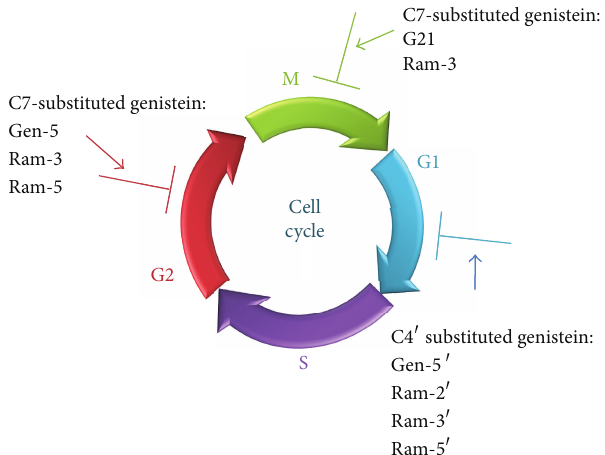
Figure 10: Cell-cycle arrest by differently substituted genistein derivatives.